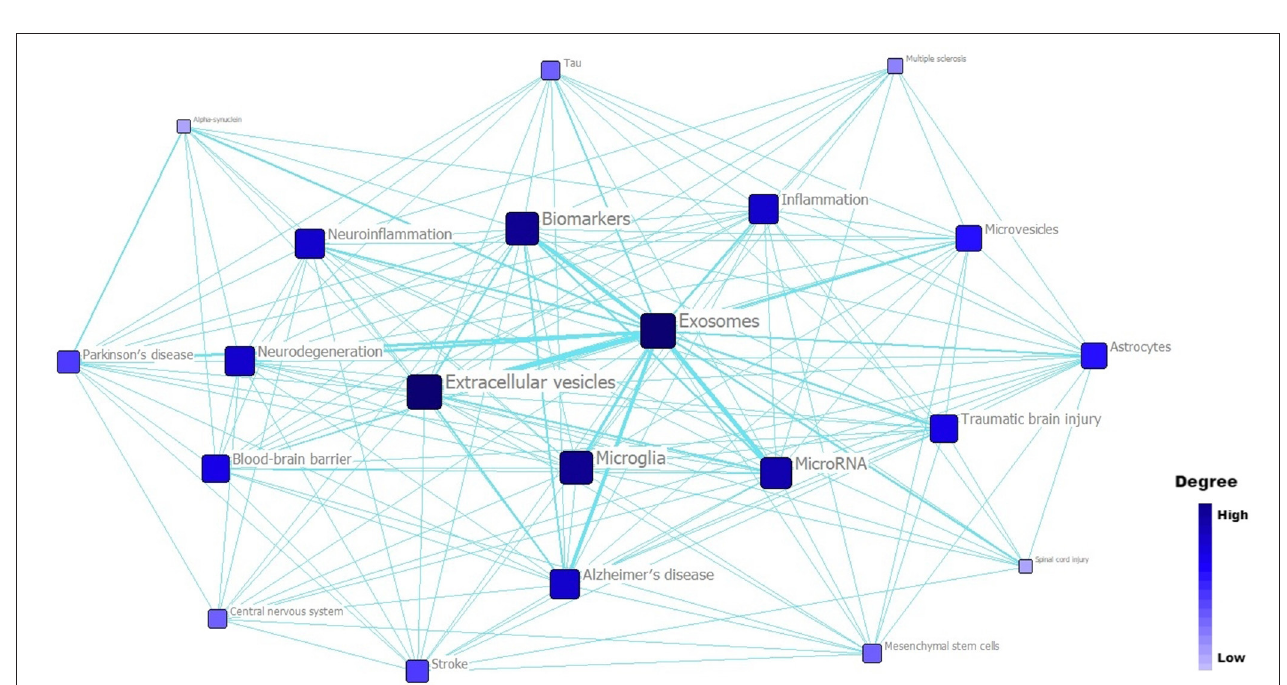
FIGURE 7 | Social network analysis of top 21 high-frequency words related to exosomes in the field of